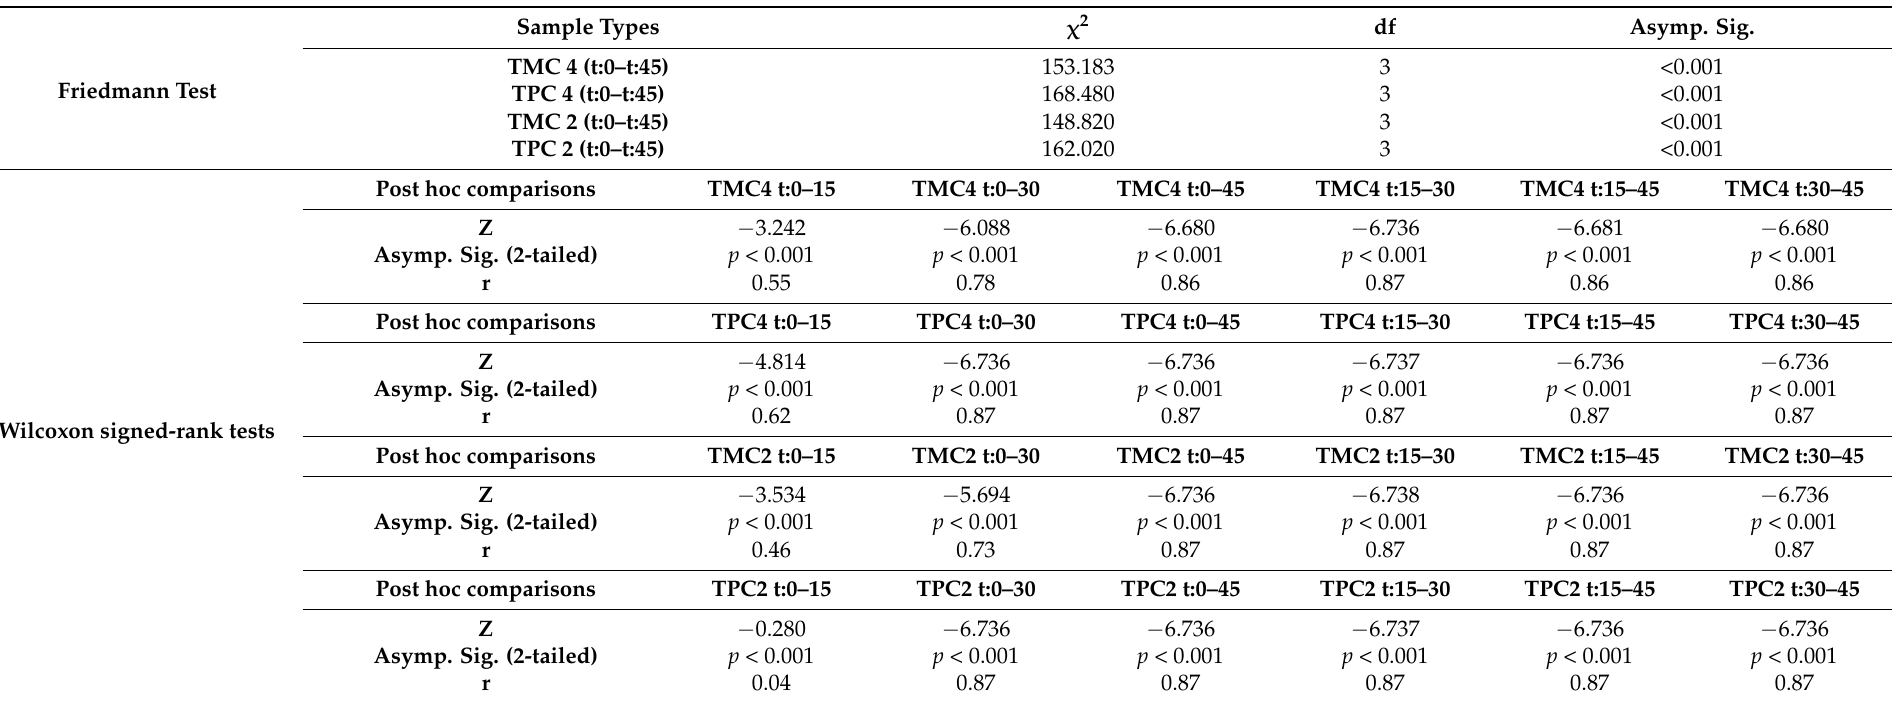
Table 6. Nonparametric statistical (Friedmann and Wilcoxon) results for shelf life